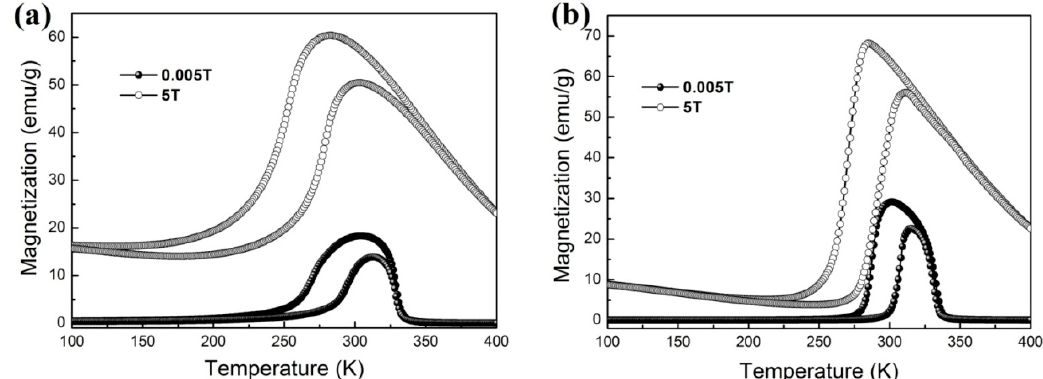
Figure 5. ( a ) Thermo-magnetic (M–T) curves measured under the field of 0.005 T and 5 T for melt-spun ribbons. ( b ) M–T curves measured under the field of 0.005 T and 5 T for annealed ribbons.